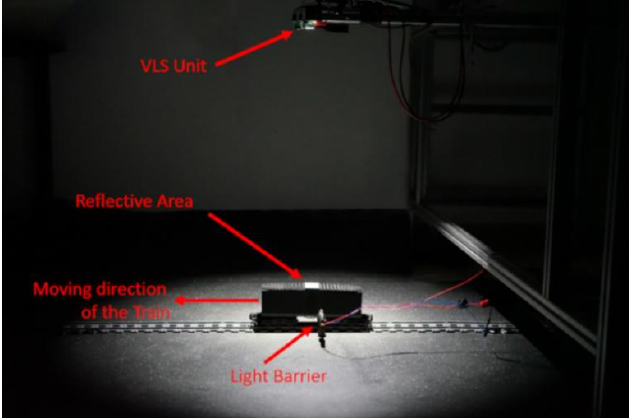
Figure 4. Experimental setup.